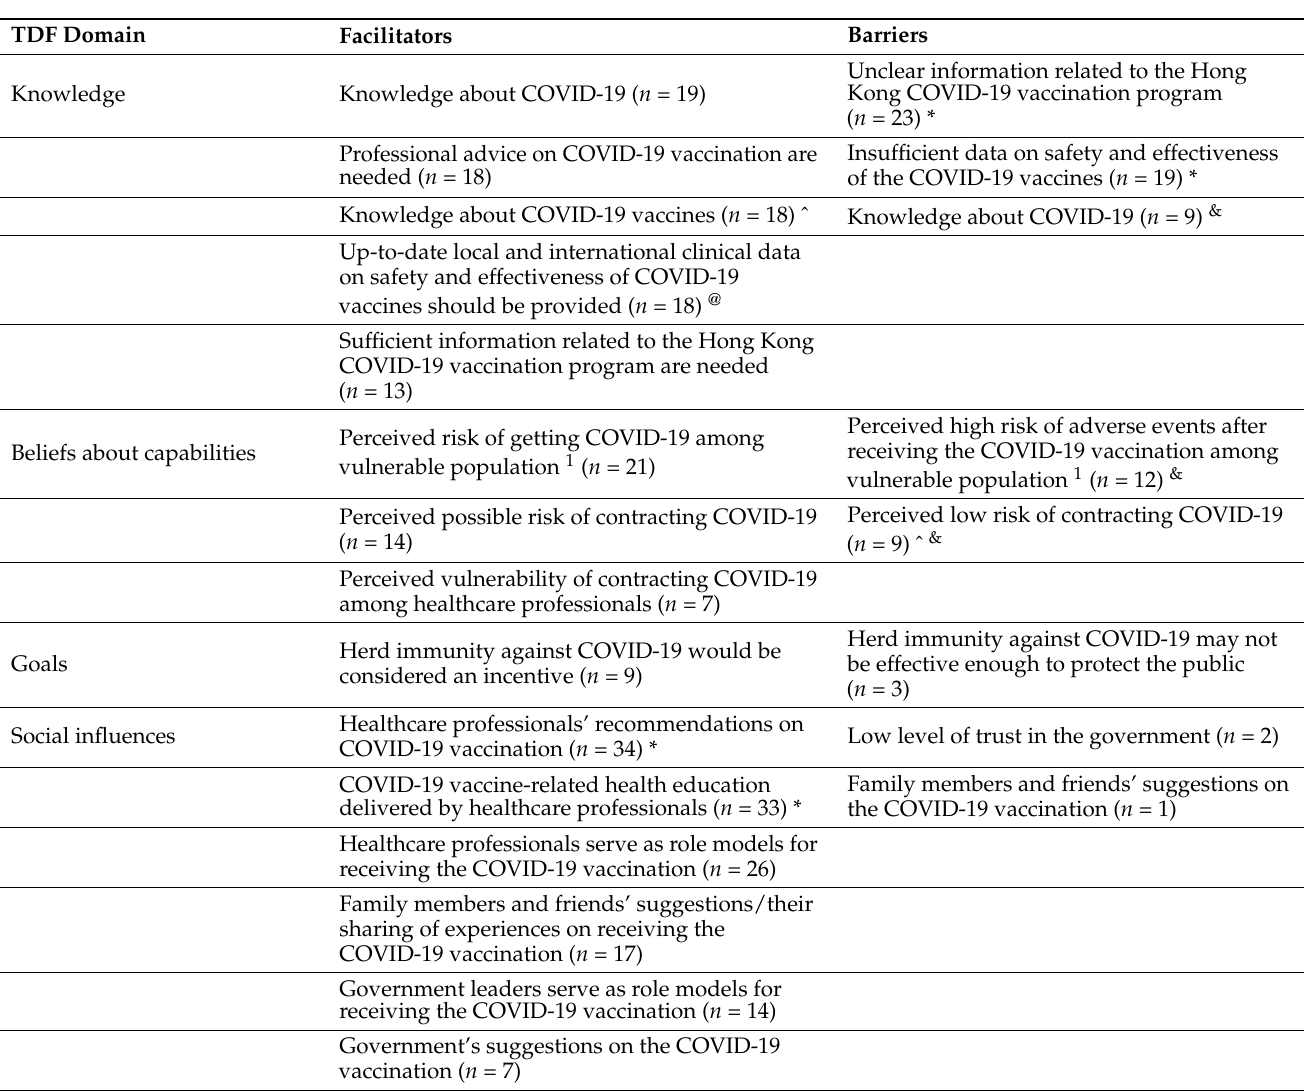
Table 2. Summary of facilitators of and barriers to the COVID-19 vaccination presented under the TDF ( n =